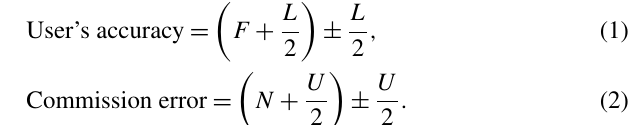
(Table 1) was selected as the most suitable: detections